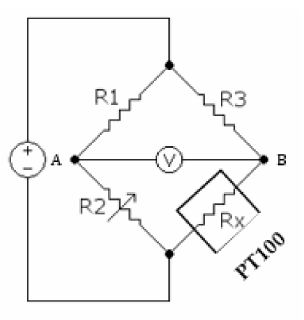
Figure A1. PT100 Probe.